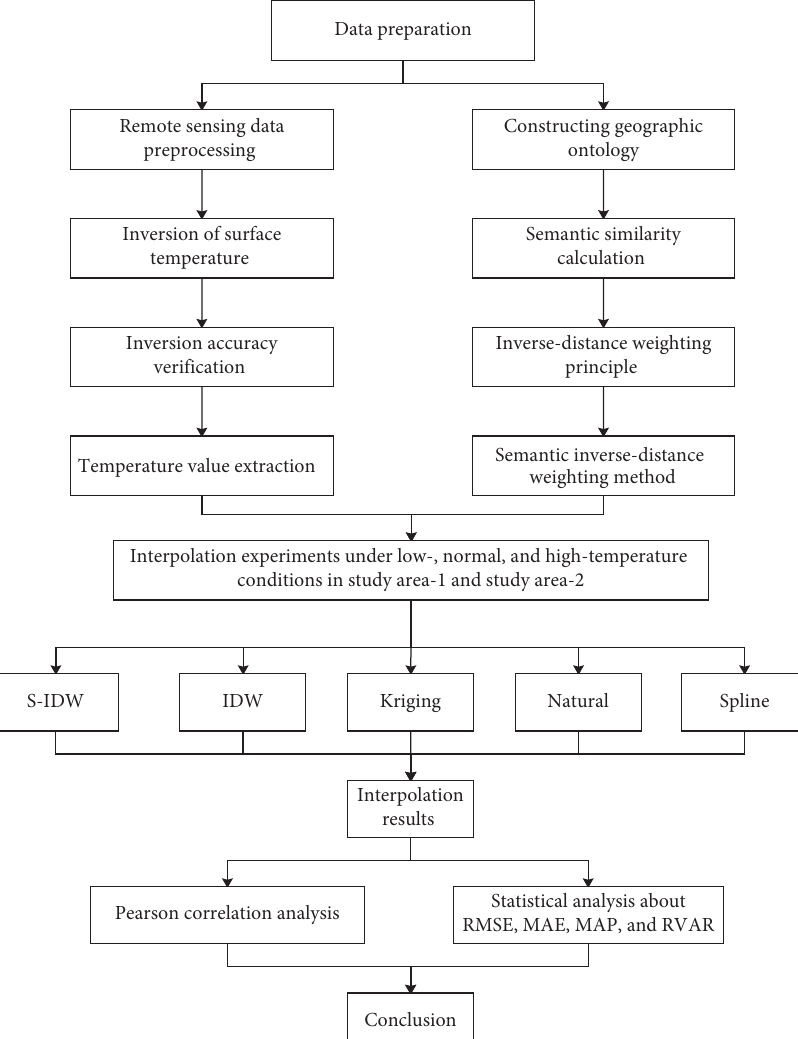
Figure 2: Experimental flow chart of semantic inverse-distance weighting